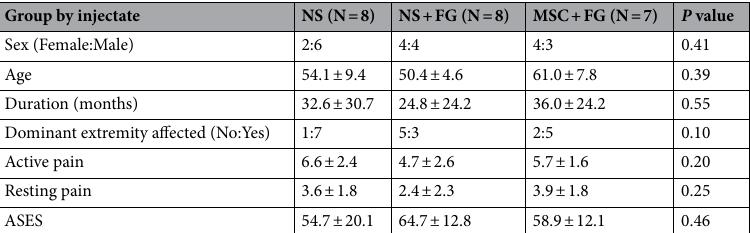
Table 1. Baseline characteristics by group. Values are presented as the mean ± standard deviation or as a number (%). P values were obtained using Kruskal–Wallis tests for continuous variables and chi-square tests for categorical variables. NS normal saline, MCS mesenchymal stem cell, FG fibrin glue, ASES American Shoulder and Elbow Surgeons score, UCLA University of California, Los Angeles shoulder score, DASH Disabilities of Arm, Shoulder and Hand